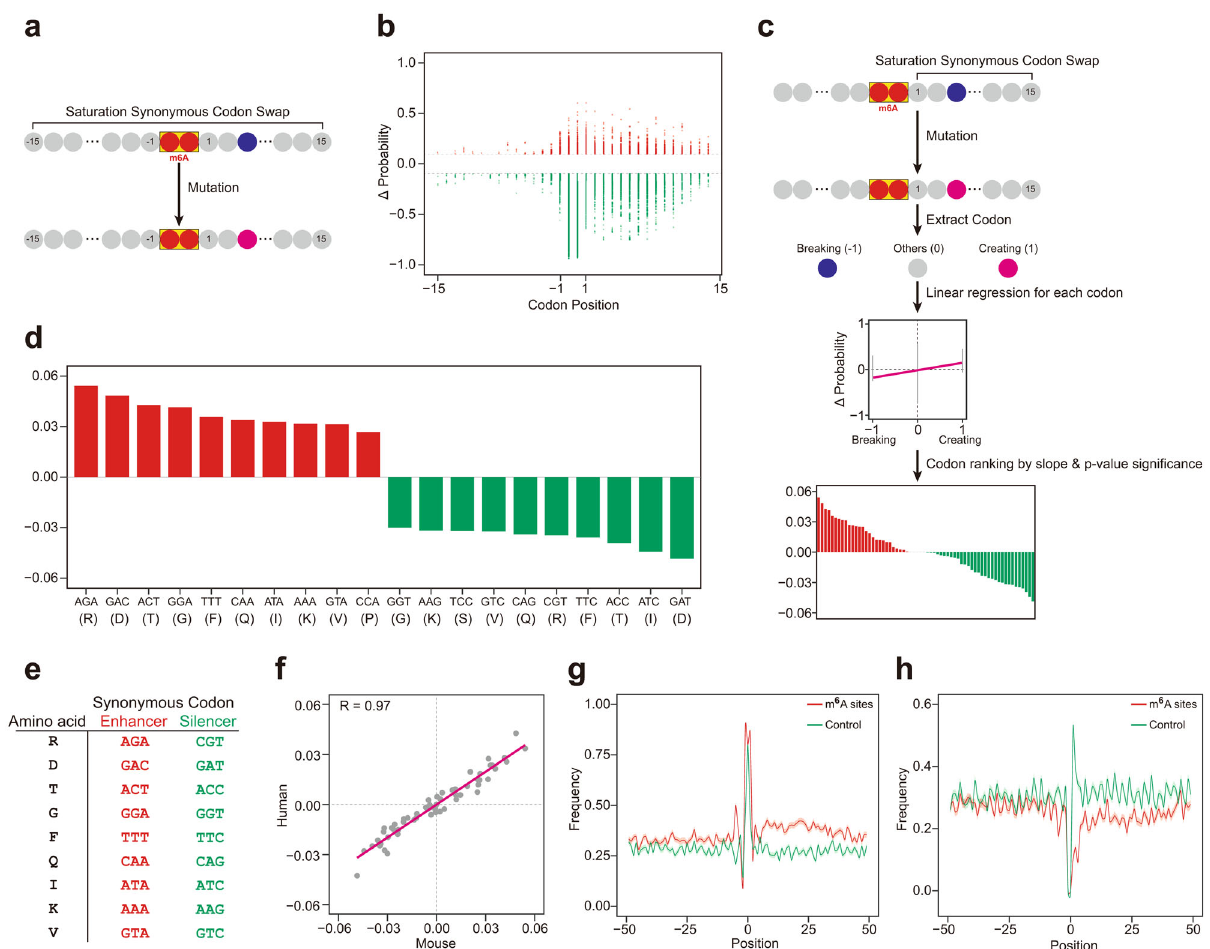
Fig. 5 Synonymous codons may in fl uence m 6 A deposition. a The saturation synonymous codon swap strategy. For each codon in codons ( − 15 to + 15 codons, − 45 nt to + 45 nt) around the m 6 A site, the codon was substituted by each of its synonymous codons. The delta changes of m 6 A probability value ( Δ Probability) after swap was calculated by iM6A. b Positional plot of Δ Probability (cutoff = 0.1) for saturation synonymous codon swap. Red color dots were those codon swap events that increased m 6 A probability; Green color dots were those codon swap events that decreased m 6 A probability. c The systematic and quantitatively determination of the effect on m 6 A deposition for all codons by linear regression (See details in Methods). Total number of m 6 A sites used was 1473. (The full list of effect values for each synonymous codon are listed in Supplementary Data 3). d Bar plot of effect values for top 10 enhancer codons and top 10 silencer codons, its corresponding amino acids were also labeled. e Synonymous codon pair in enhancing and silencing m 6 A deposition. The amino acids (the fi rst column) were coded by the synonymous codons (the second and third columns, respectively), which the enhancer codons enhancing m 6 A deposition, and the silencer codons silencing m 6 A deposition. f Scatter plot for the effect correlation for all synonymous codons between the study of human synonymous codons and the study of mouse synonymous codons. The effect of each synonymous codon was determined by the slope of its linear regression equation, and each gray dot was a synonymous codon. g , h Positional plot for the frequency of Top 20 enhancer codons ( g ) or silencer codons ( h ) in the sequences around the m 6 A sites. The plots were compared between higher m 6 A probability sites (red color, probability ≥ 0.7) and lower m 6 A probability sites (the exact RAC motif matched control, probability < 0.01). Data were presented as mean ± SEM. (Using other top number of enhancer or silencer codons generated similar two groups according to their stop codons (TGA or non-TGA), and found that transcripts with the m 6 A sites at and adjacent to stop codons were statistically enriched with the TGA stop codon ( P < 1 × 10 − 4 , Fisher ’ s exact test) (Fig. 6e for mouse, and Sup-